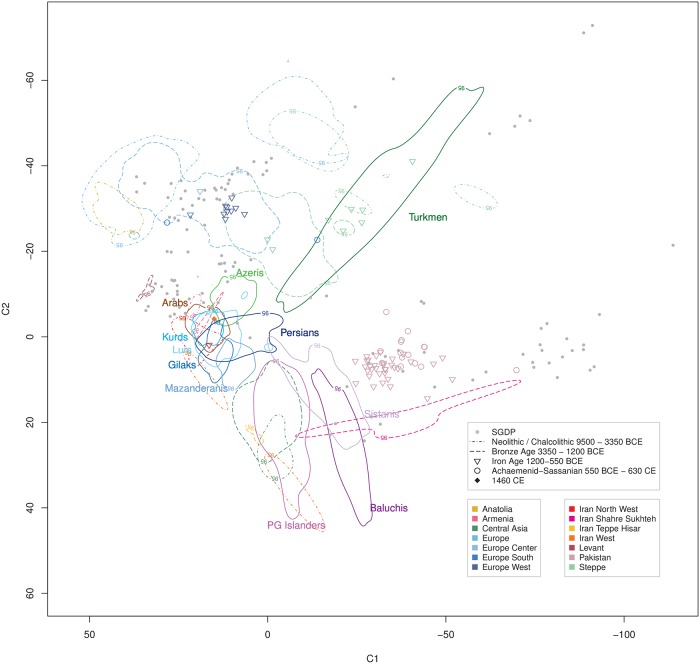
Ancient DNA samples from 1200 BCE–1460 CE in the context of extant Iranian ethnic groups.Time-period specific ancient DNA samples (S3 Table) projected onto extant human variation (S18 Fig). The geographic origin of the ancient samples is coded by color. Previous time strata are indicated by 95% density limits (refer to Figs 5 and 6).